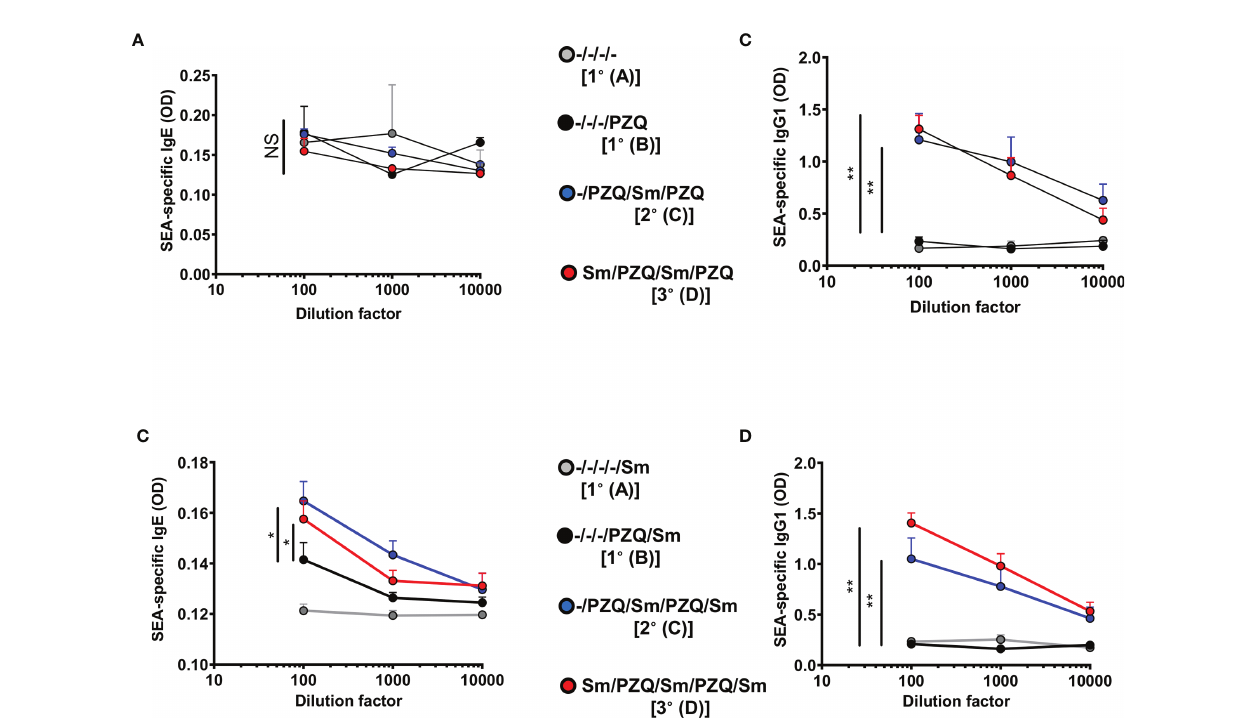
FIGURE 3 | SEA-speci fi c antibodies in serum after repeated cycles of S. mansoni infection and PZQ treatments. Outcome measure = Parasite-speci fi c antibody responses in animals. Serum was isolated from animals at the end of the follow-up periods of 15 weeks (P1) and 25 weeks (P2) and parasite-speci fi c antibody responses were measured by ELISA i.e. P1 Egg antigen-speci fi c IgE (A) , IgG1 (B) and P2 Egg antigen speci fi c IgE (C) and IgG1 (D) are shown. Data shown are means ± SEM from one of 2 experiments, with 4-7 mice per group in each experiment. NS = p > 0.05; * = p < 0.05; ** = p < 0.01 as determined by Kruskal-Wallis test with correction for multiple comparisons by Dunn ’ s test for the 100 x dilution